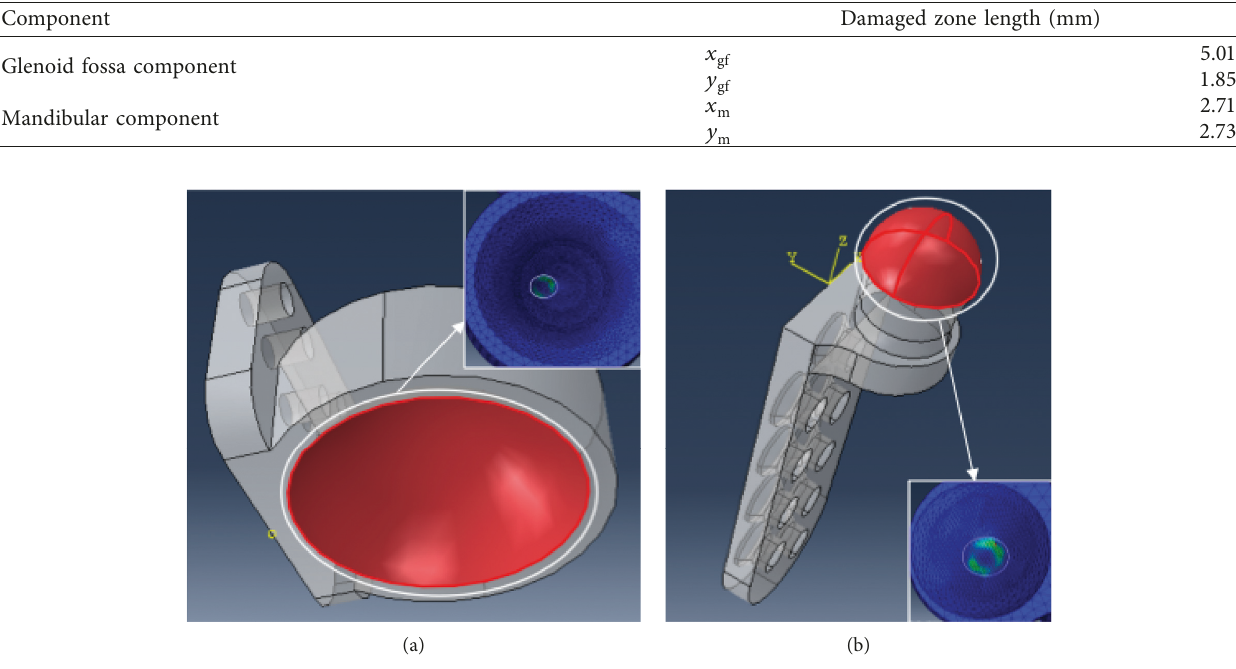
Figure 6: Evaluation of contact stresses at (a) the glenoid fossa and (b) mandibular components.